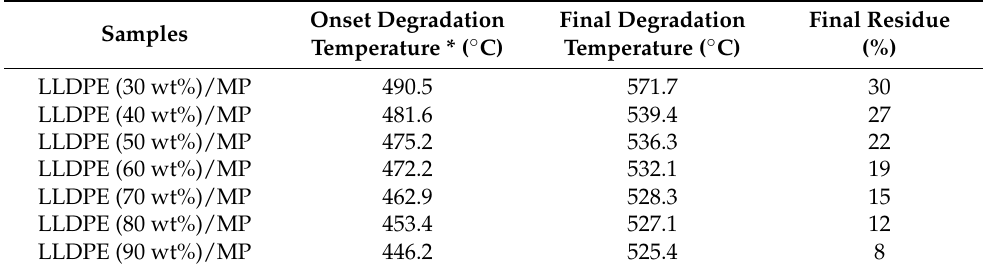
Table 4. Thermogravimetric analysis (TGA) result for 30 to 90 wt%